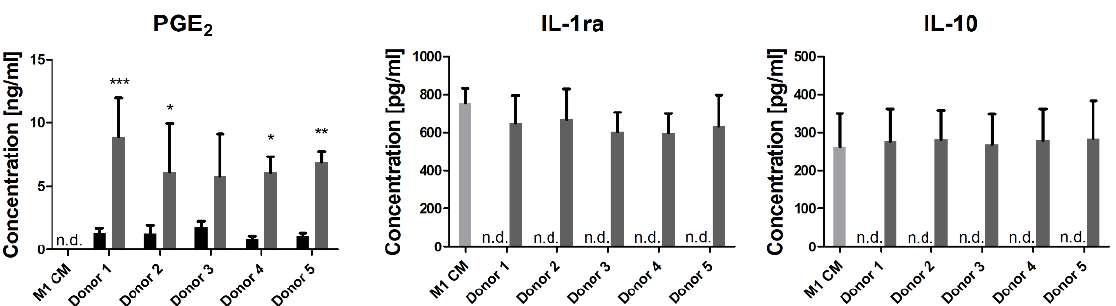
Figure 1. IL-1ra, IL-10, and PGE2 secretion of hMSCs upon stimulation with the conditioned medium of polarized THP-1 M1 macrophages. Present initial concentrations from M1 CM are depicted for reference (light gray bars). hMSCs from five donors were incubated for 24 h with the M1-conditioned medium (+M1 CM, dark gray bars) or without (black bars). Significance was determined between control and treatment for each donor using two-way ANOVA and Sidak’s post hoc test. Between donors, no significant difference was found in any case. TSG-6 was not detectable in all controls and treatments. * = p < 0.05; ** = p < 0.01; and *** = p < 0.001. n = 3. Abbreviation: n.d., non- detectable.